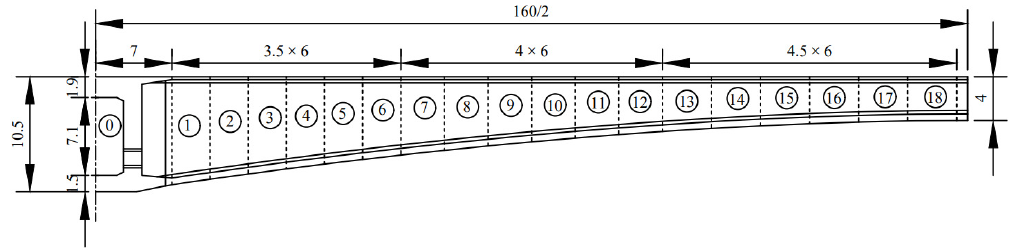
Figure 3. General structural drawing of main bridge box girder (m). Table 1. Weight and length of suspended beam section of Pier